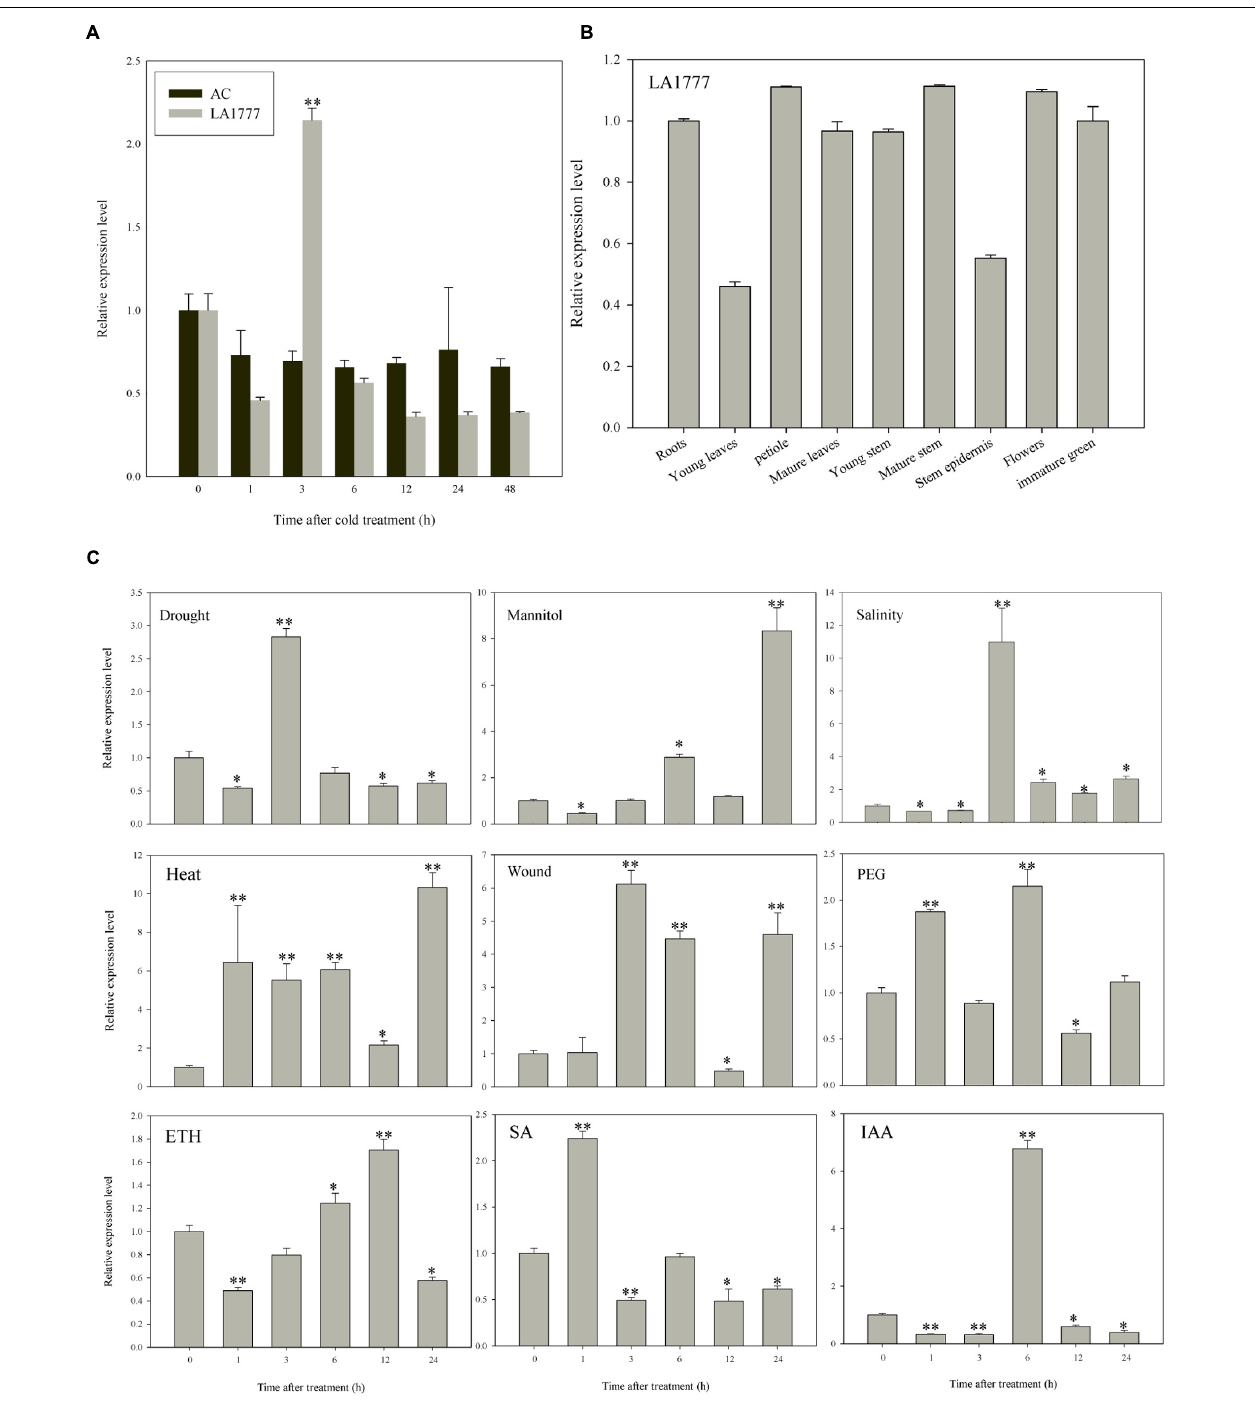
FIGURE 2 | Expression patterns of tomato ATL78L in different tissues or under various abiotic stresses and hormonal treatments. (A) Expression levels of ATL78L in Solanum habrochaites LA1777 and Solanum lycopersicum cv. Ailsa Craig under cold stress. Asterisks indicate significant differences between LA1777 and AC ( ∗ P < 0.05; ∗∗ P < 0.01, Student’s t -test). (B) Expression pattern of ShATL78L in different tissues of LA1777 plants. (C) Expression patterns of ShATL78L in LA1777 seedlings under drought, salt, heat, wound, mannitol, PEG, ETH, SA, and IAA treatments. Asterisks indicate a significant difference ( ∗ P < 0.05; ∗∗ P < 0.01, Student’s t -test) compared with the corresponding controls. Four-week-old seedlings were treated by 4 ◦ C, 200 mM NaCl, 40 ◦ C, 200 mM mannitol, 30% PEG6000, 0.2 mM ETH, 0.1 mM SA or 0.1 mM IAA, respectively, for indicated time points. Values are means ± SE of three biological replicates. Each replicated sample consists of leaves from three